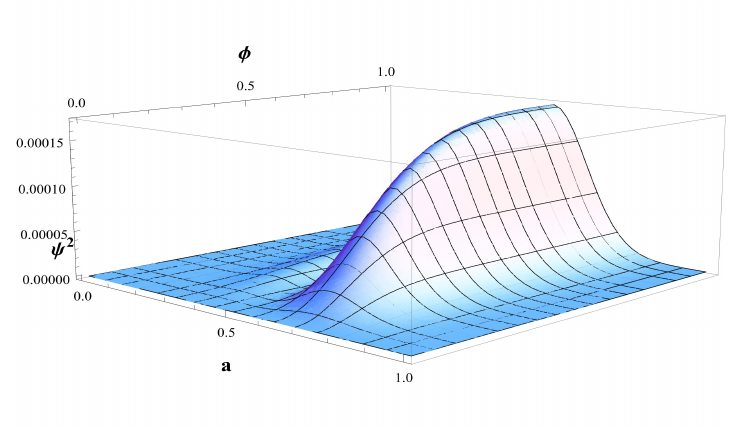
Figure 4. Numerical profile of ψ ( a , φ ) 2 corresponding to (7), with β = − 100, k = 0, c 1 = 1, c 3 = c 5 =